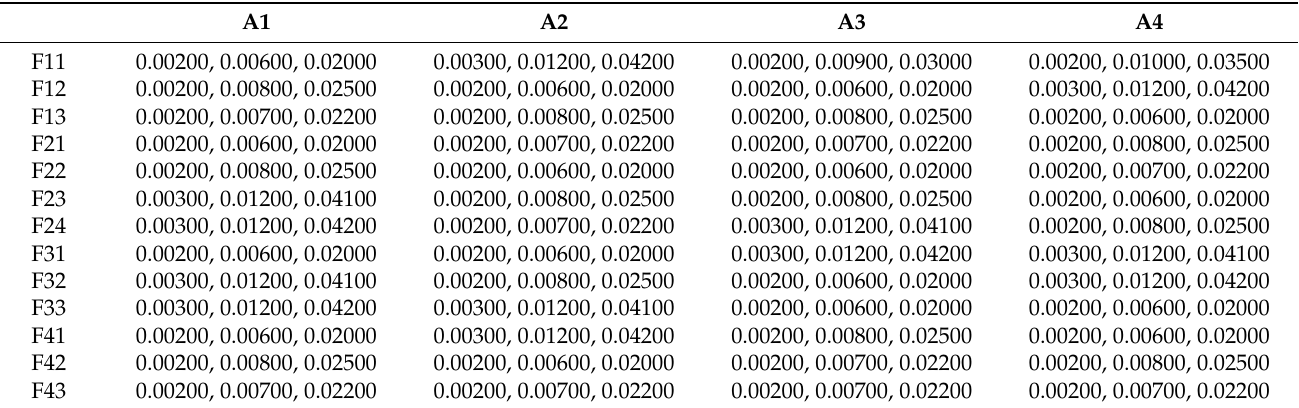
Table 5. Weighted normalized fuzzy decision